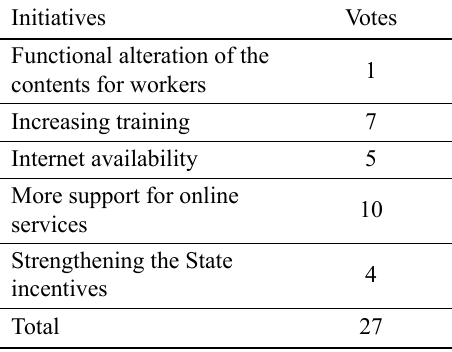
Table 13. Initiatives that potentiate an inclusive information society Initiatives Votes Functional alteration of